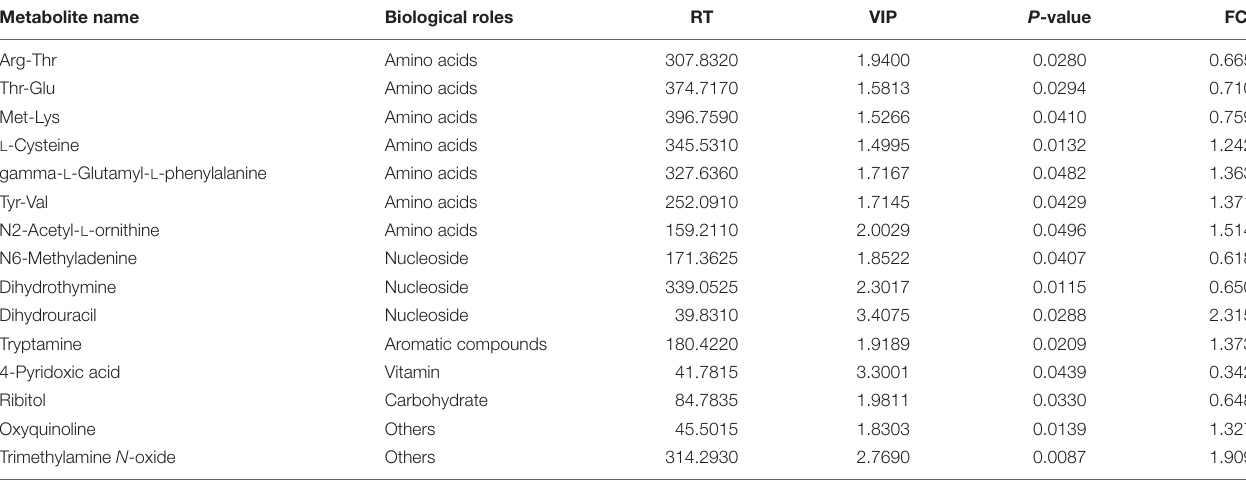
TABLE 4 | Identification of significant differential metabolites between the OPC group and HIS group.